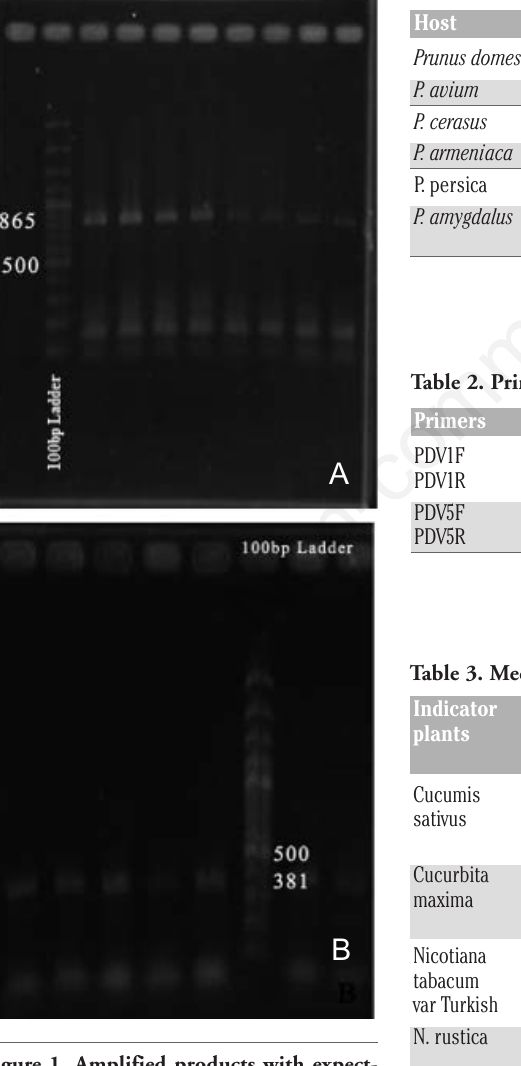
Table 1. Natural host range of PDV and its symptoms.